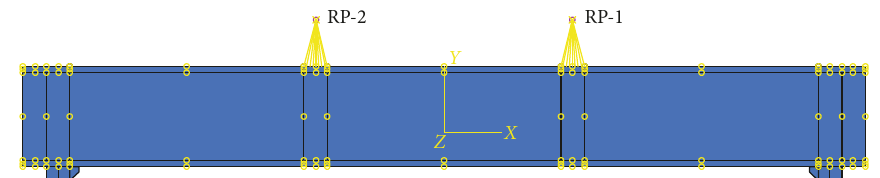
Figure 8: Finite element analysis model.